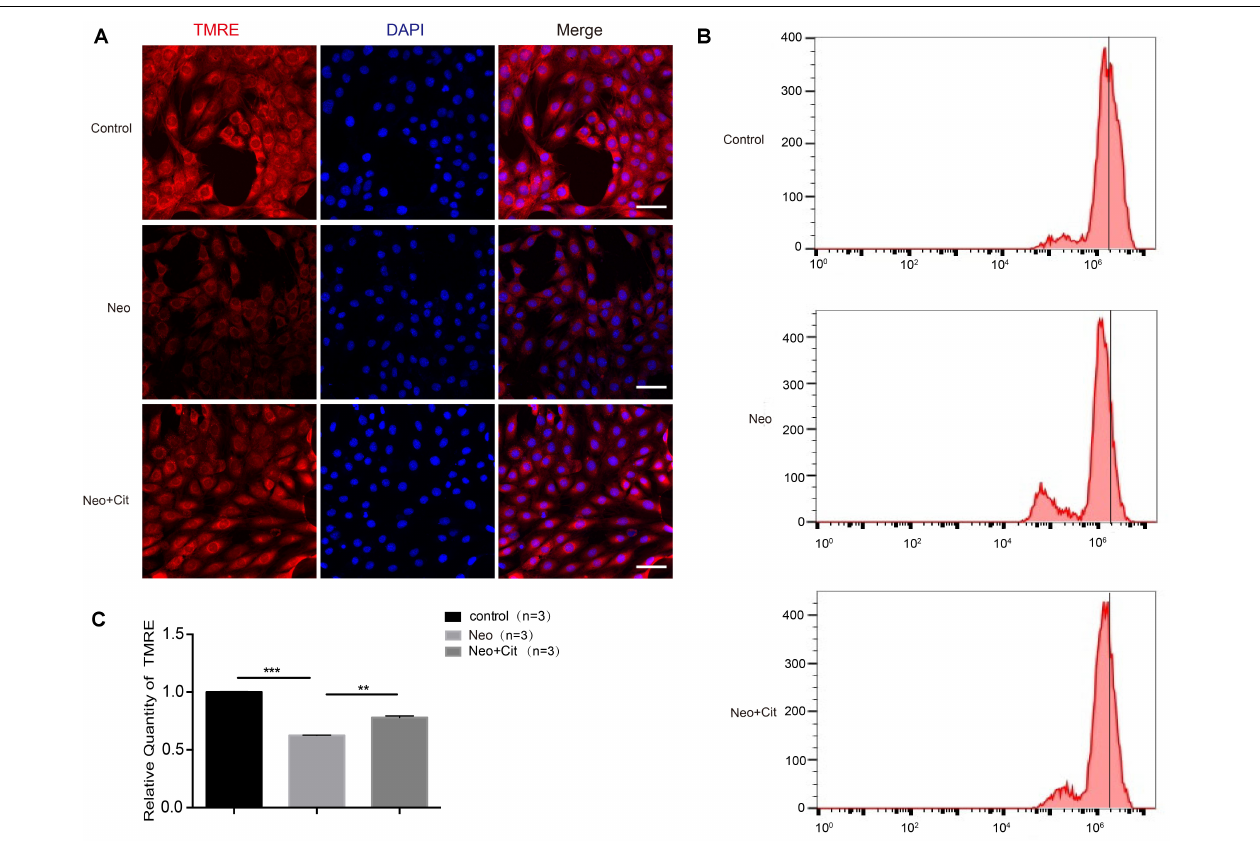
FIGURE 6 | Citicoline increases the MMP of HEI-OC-1 cells after neomycin exposure. (A) The three groups of HEI-OC-1 cells were labeled using the TMRE staining kit. (B) Flow cytometry data confirmed the results in (A) . (C) Quantification of the flow cytometry results in (B) . The TMRE intensity was significantly decreased after neomycin exposure compared to the undamaged controls. In addition, the TMRE intensity was significantly increased in the citicoline treatment group compared to the neomycin-only group. Data are shown as mean ± SD. * p < 0.05, ** p < 0.01, *** p < 0.001. Scale bars = 20 µ